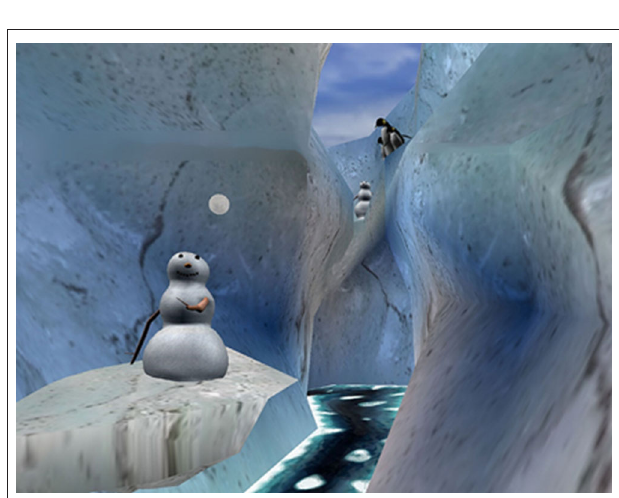
FIGURE 1 | A severely burned patient looking into the VR goggles during burn wound care in the ICU tank room. Copyright Hunter Hoffman, U.W., www. vrpain.com.